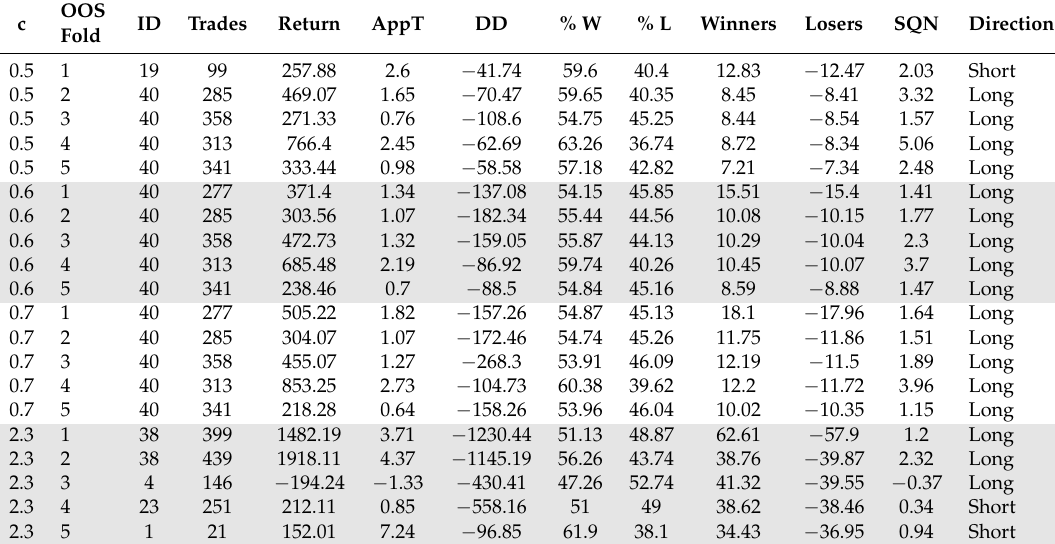
Figure 14. A horizontal blue line is set at 0.05 level, which defines the threshold for the p -values to be considered as statistically significant enough to reject the null hypothesis that the rule has no predictive power. The x-axis represents the average relative size of the winning trades, calculated as ¯ r ¯ r the mean return of the strategy analysed and v th the 95% quantile for the volatility in the 1-min timeframe (which is equal to 7.3 pips). Values of this quotient close to 1 produces unreliable results. Performance metrics of the four selected strategies in the 60-min timeframe are shown in Figure 15 and Table 10. Summary of the equity curve resulting for the out-of-sample period for these four strategies is shown in Table 11. Table 10. It can be seen that the vector comprising the optimum sequence of candlestick patterns is very similar for coefficient values which are very